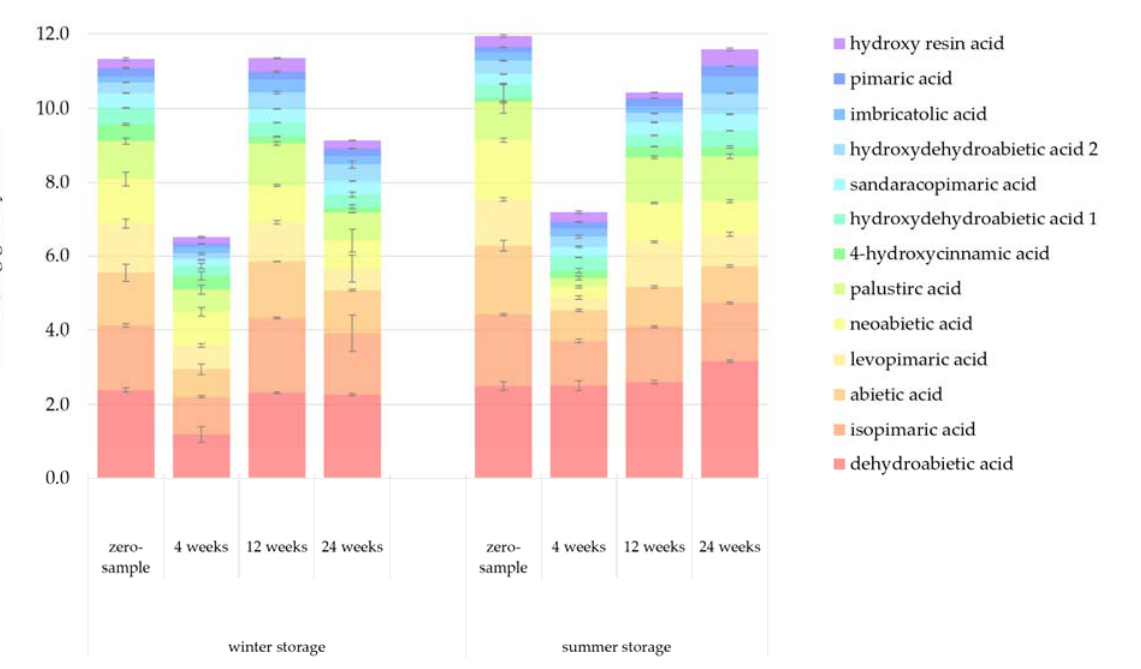
Figure 6. Changes in resin acids during summer and winter storage periods of saw log bark.